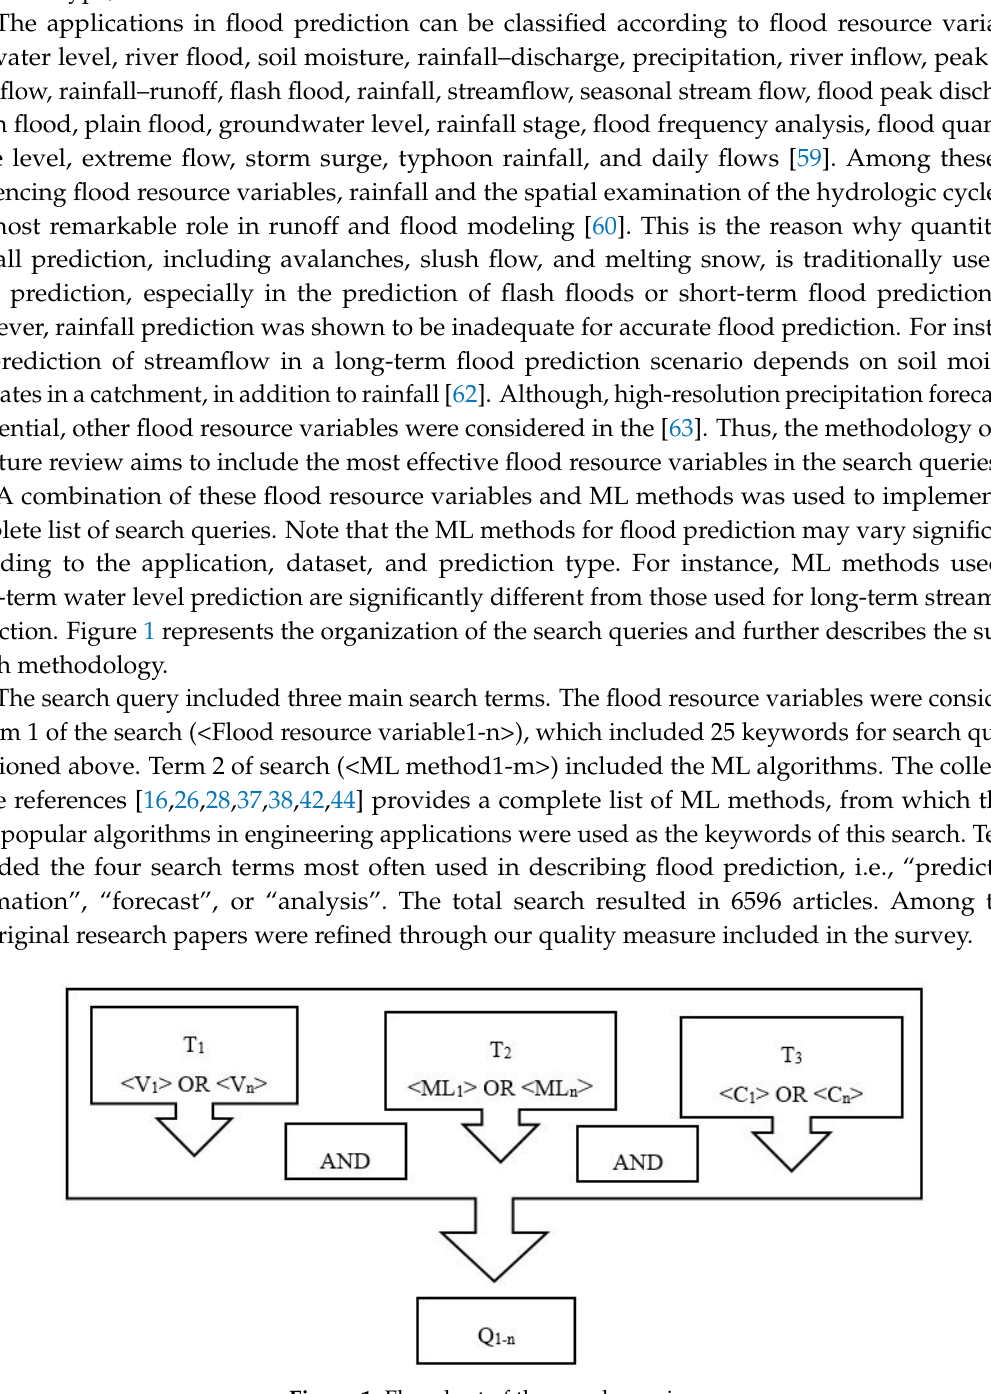
Figure 1. Flowchart of the search queries.